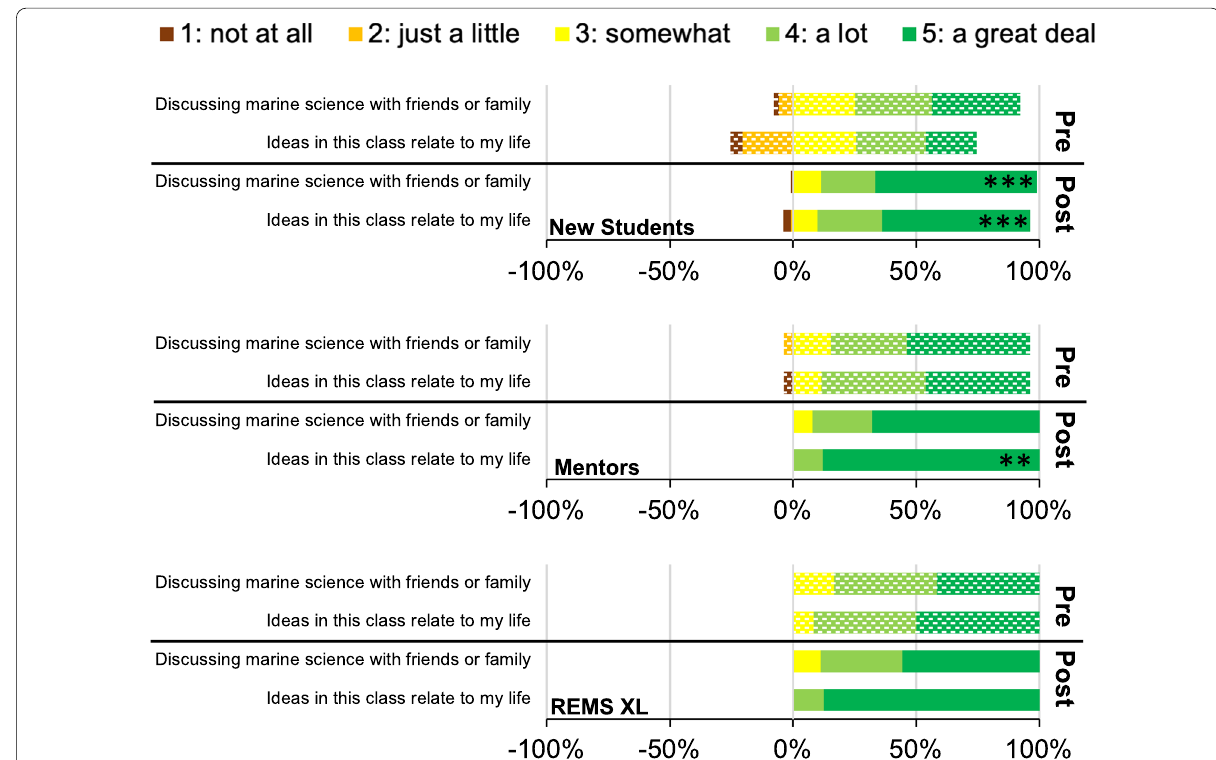
Fig. 22 Recognition: Pre- and post-program personal relevance of marine science. Student responses (New Students ( N REMS XL (12)) to REMS survey items (1 post-program differences were analyzed with a Mann–Whitney U -test. ** p < 0.01. *** p <